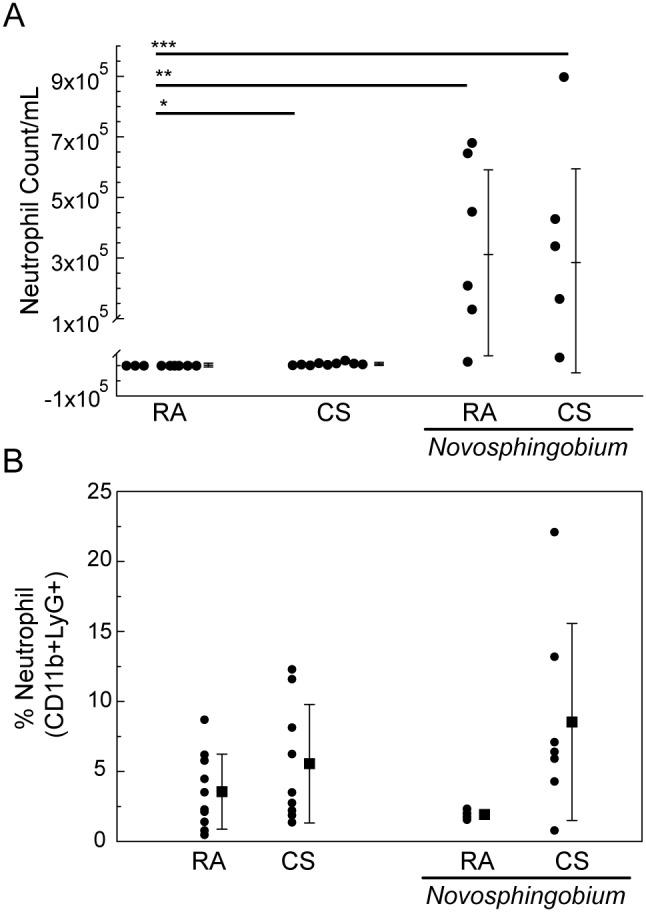
Neutrophil cell counts.(A) Differential counts for neutrophils were assessed ex vivo using cytospin smears of BAL samples. Results were expressed as total cell number/mL. (B) Neutrophil Inflammatory responses assessed ex vivo by flow cytometry on mouse lung tissue-recovered cells. For each mouse experimental group, 50,000–100,000 events were collected on an LSRII flow cytometer and analyzed for the presence of neutrophils (Ly6G+CD11b+). (One-way ANOVA test, significant at *p<0.05, **p<0.01 and ***p<0.001).